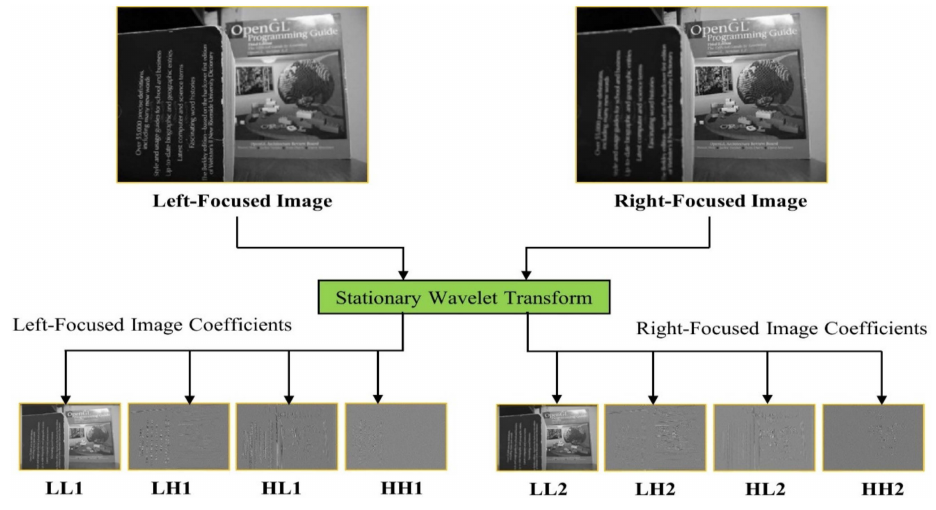
Figure 2. SWT decomposition